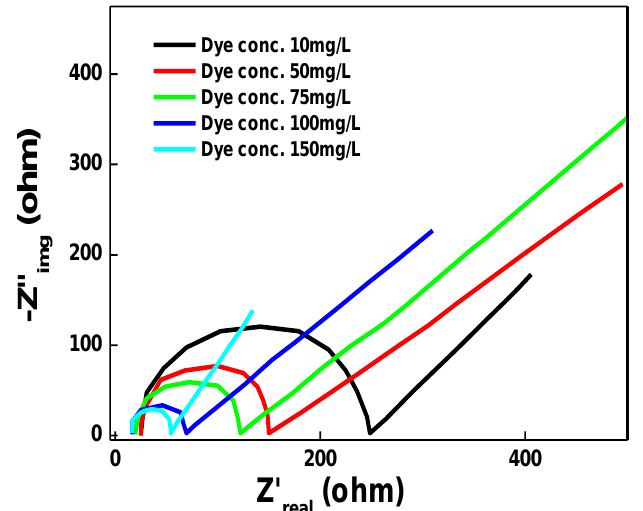
Figure 6. Nyquist plot of MFCs with different concentrations of Congo red in the medium.